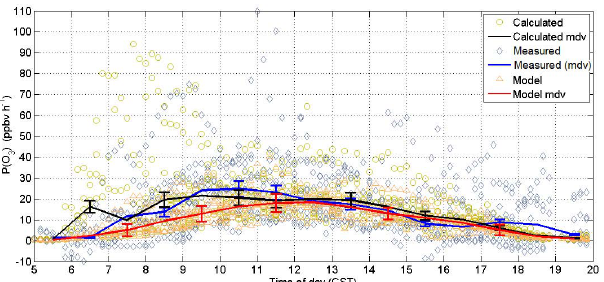
Fig. 2. Overlapping 10-min points and median diurnal variation (mdv) for calculated (yellow circles and black line), measured with the MOPS (light blue diamonds and blue line) and modeled P (O 3 ) (orange triangles and red line). Comparison is done for overlapping data only during daylight hours in Central Standard Time (CST). Er- ror bars are 1 σ based on measurement uncertainty for the GTHOS and MOPS instruments and on calculated model uncertainty at dif- ferent times of the day.